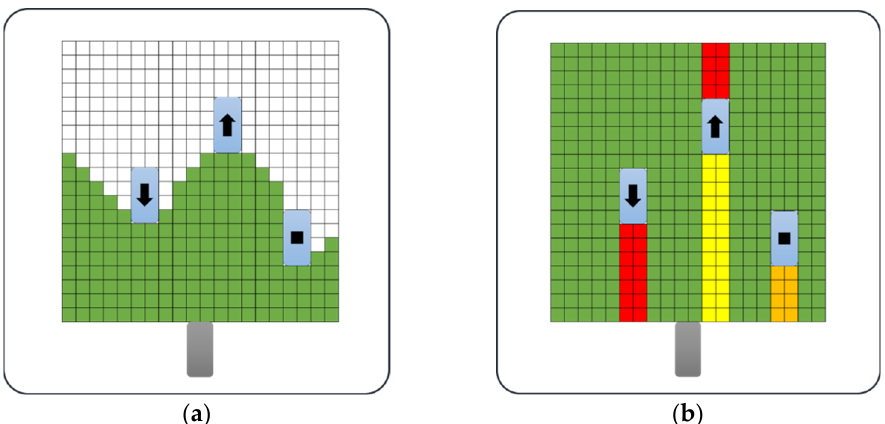
Figure 5. Free space detection with polygon and free space detection with segments: ( a ) polygon method of previous paper; ( b ) proposed segmentation method.